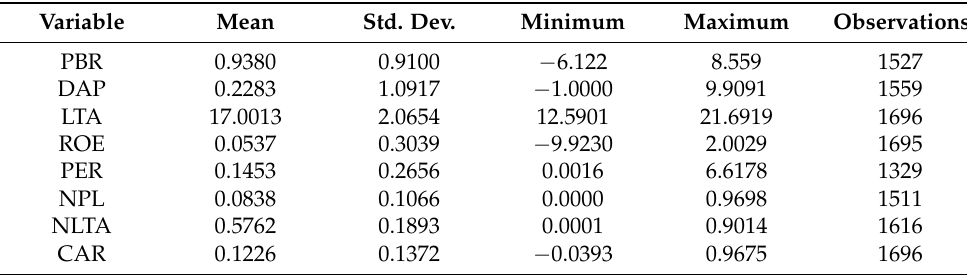
Table 3. Descriptive